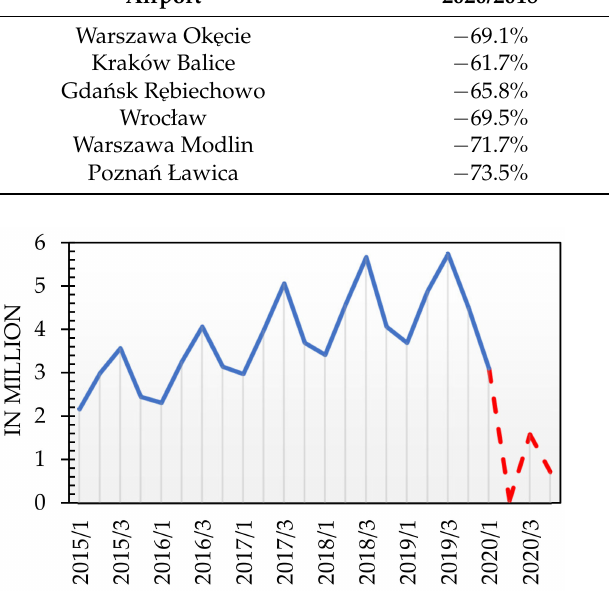
Figure 1. Number of passengers at Warsaw Ok˛ecie Airport.